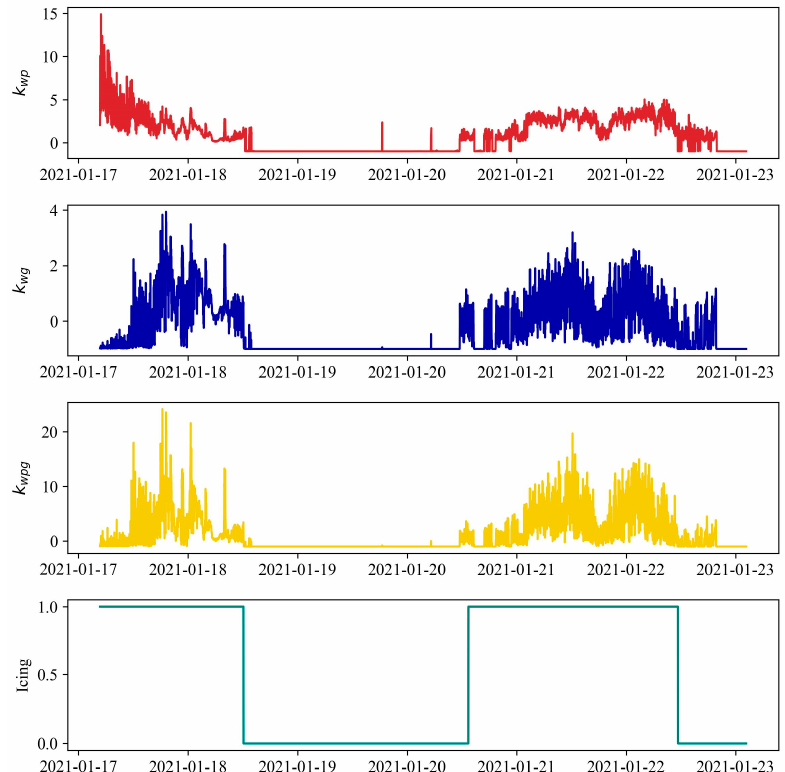
Figure 4. Waveform plot of the new fusion features.